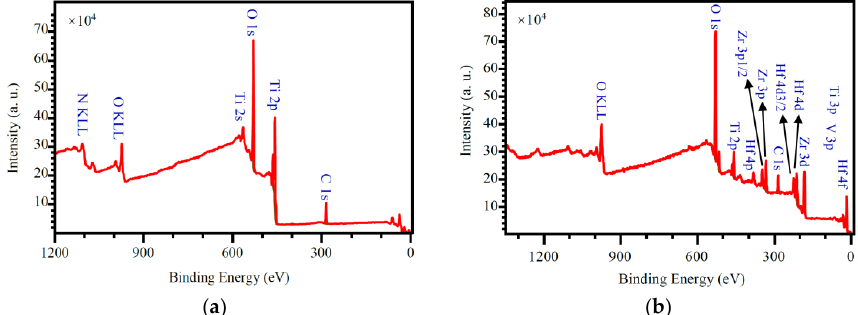
Figure 4. The X-ray photoelectron spectroscopy (XPS) survey spectra for the surfaces of ( a ) Ti film and ( b ) Ti–Zr–V–Hf quaternary alloy film coatings.